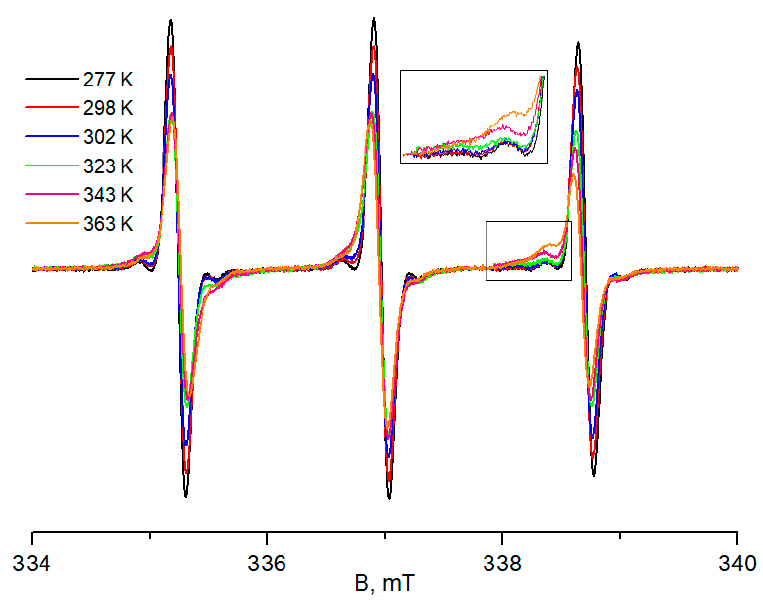
Figure 2. EPR spectra of TEMPO in polymer IV solutions (5 wt%, PBS) at 277–363 K. Table 2. Hfc constants a iso and rotational correlation time t corr,iso for TEMPO in solutions of thermore- sponsive polymers and VPTT of the polymers in 5 wt% and 10 wt% aqueous solutions. T sim —the temperature of solutions, the spectra of which were simulated. T start —the initial temperature for the decay of the signal